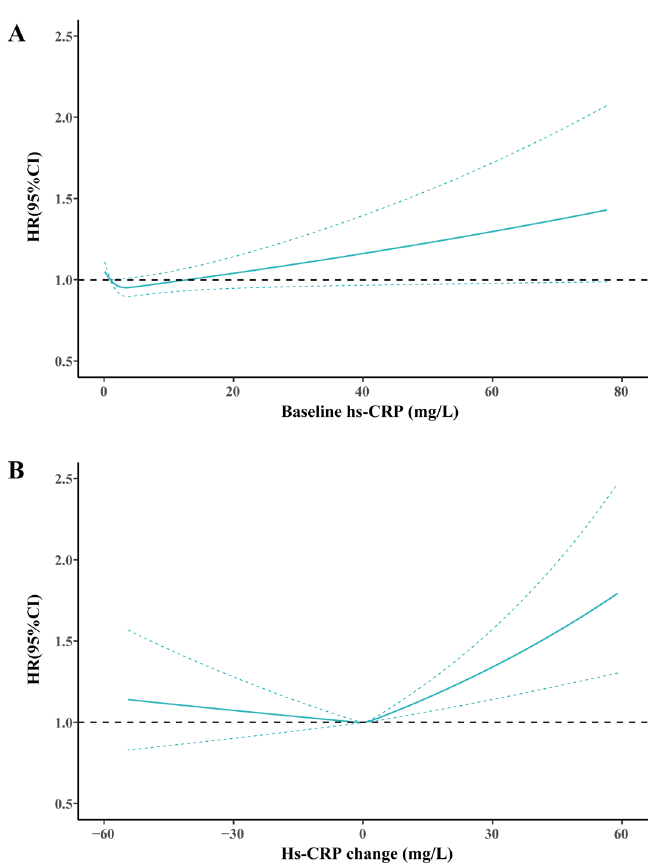
Figure 2. ( A ) Restricted cubic spline for the association of baseline Hs-CRP (as a continuous variable) with cognitive impairment. ( B ) Restricted cubic spline for the association of Hs-CRP change (as a continuous variable) with cognitive impairment. All covariates were age, sex, education, type of residence, marital status, BMI, SBP, depressive symptoms, chronic diseases, smoking status, drinking status, sleep duration, and global cognitive score. Reference point is 1.01 mg/L and 0 mg/L, respectively, with knots located at the 10th, 50th, and 90th percentiles. The solid lines represent multivariate-adjusted estimated hazard ratios and the dotted lines indicate the 95% CIs.